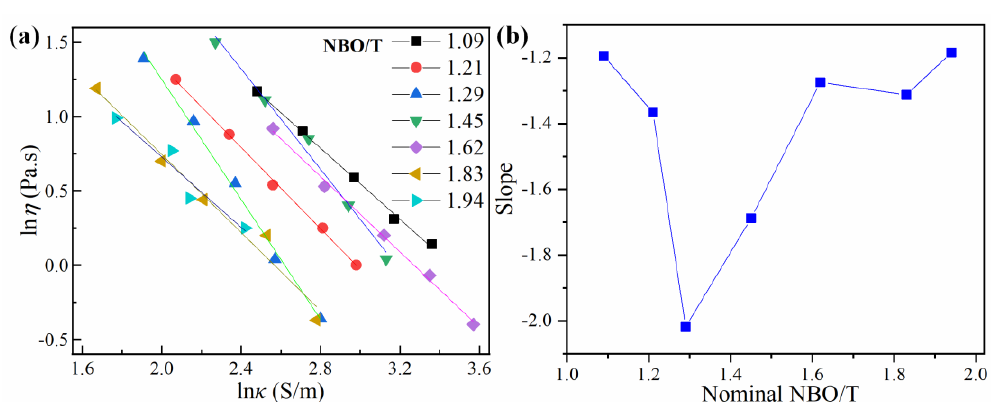
Figure 3. ( a ) Logarithm relation between viscosity and conductivity and ( b ) the linear fitting slope of CaO-MgO-FeO-Al 2 O 3 -SiO 2 systems at different NBO/T values. Table 4. Logarithm relation between viscosity and conductivity and the related parameters.